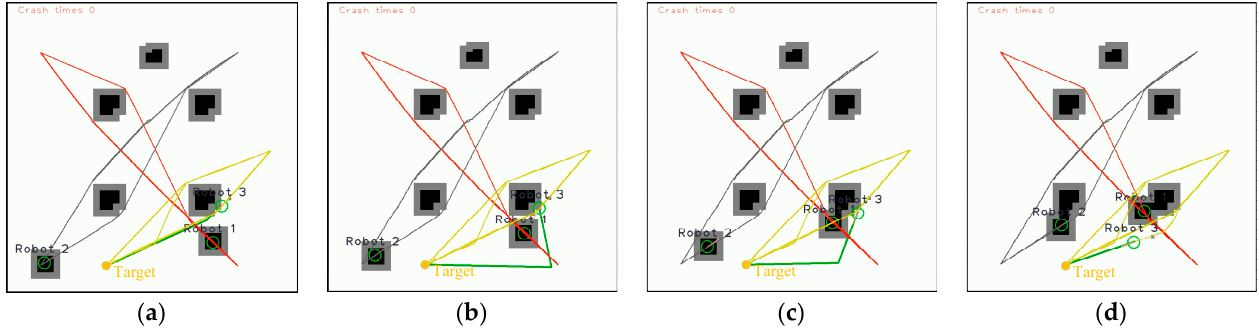
Figure 10. The path planning (green line) of robot-2 in the experiment. ( a ) Robot-1 has not yet become an obstacle to robot-2. ( b ) Robot-2 plans its path to avoid being blocked by robot-1. ( c ) Robot-1 continues to move toward the target point and then robot-2 changes its planned path to a shorter one, which passes behind robot-1. ( d ) Robot-1 gradually moves away from the area that affects robot-2.